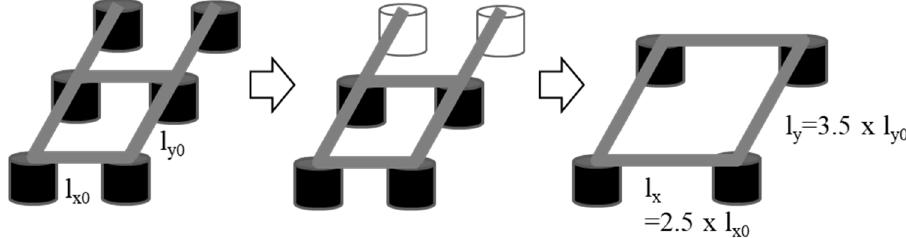
Figure 14. Suggestion for improved mount configuration design. Table 3. Comparison of resonance frequencies between the original and suggested models. Original Suggested Resonance Rank